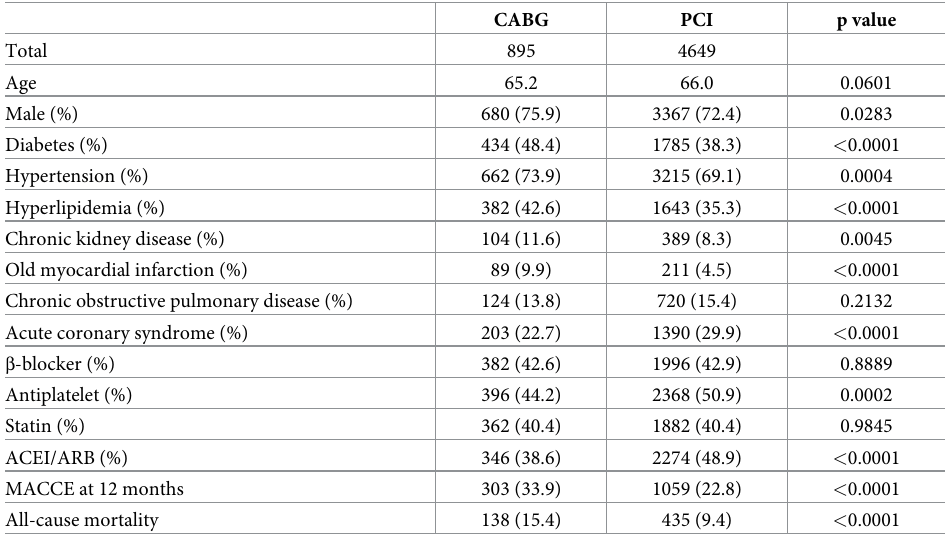
Table 1. Baseline characteristics in CABG and PCI groups.